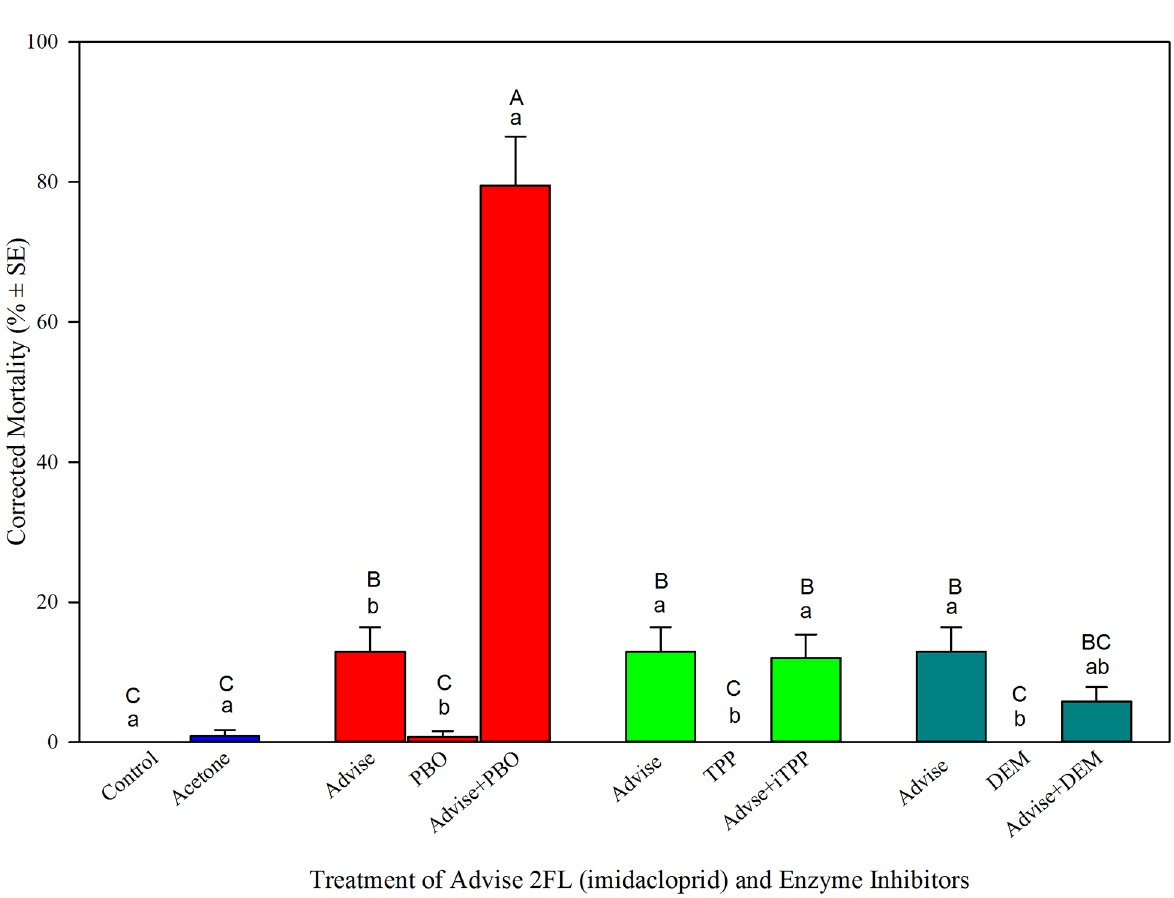
Fig 4. Roles of three major detoxification enzymesin detoxifying Advise (imidacloprid) in honey bees. PBO (piperonyl butoxide) is a cytochrome P450 oxidaseinhibitor;TPP (triphenylphosphate) is an esterase inhibitor;and DEM (diethyl maleate)is a glutathioneS- transferase inhibitor.Same letters above the error bars indicateno significantdifference:lower case letters are for within-group comparisons; capital letters refer to comparisons amongall treatments.